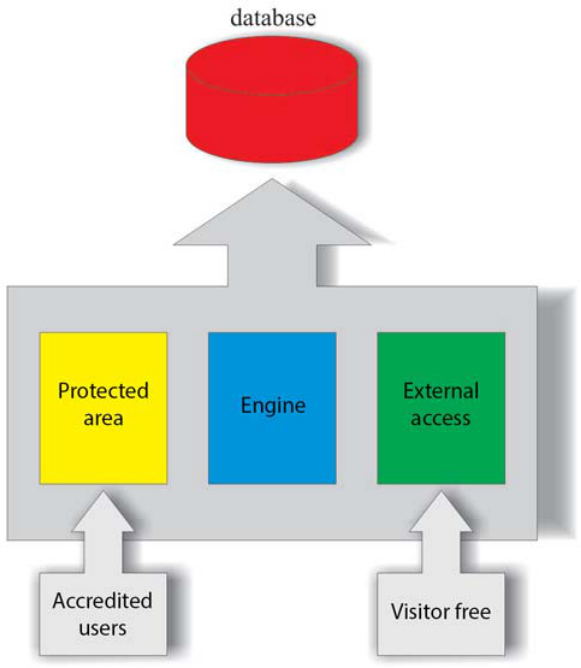
Figure 3. Schematic of the permit system adopted. Enabled users have access to protected areas.